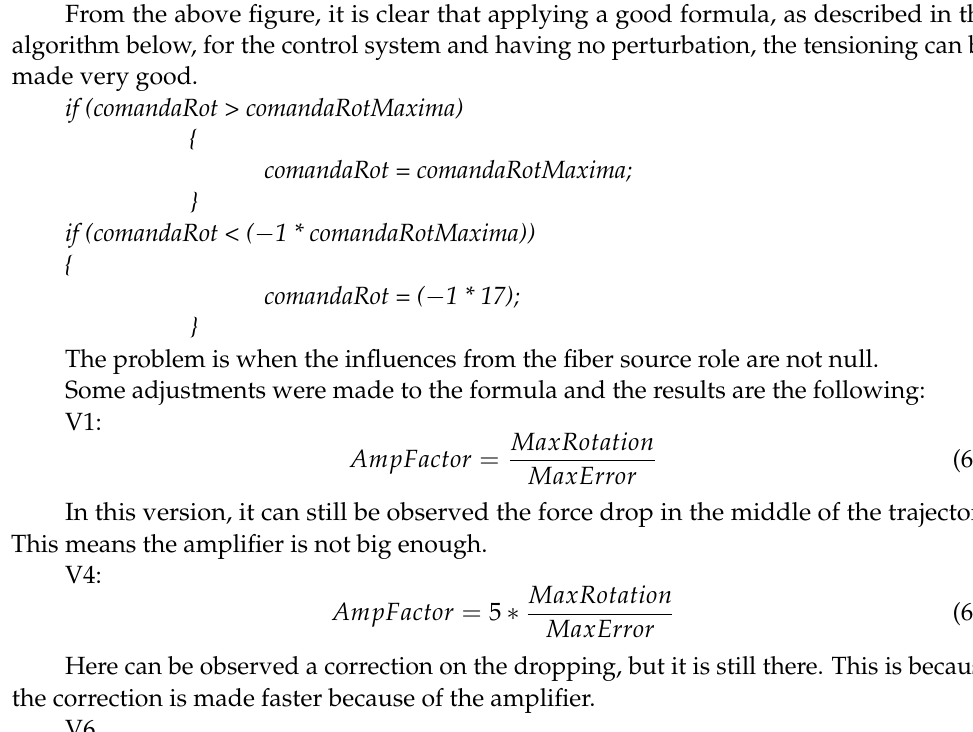
Figure 17. No role tension influence system measurements.